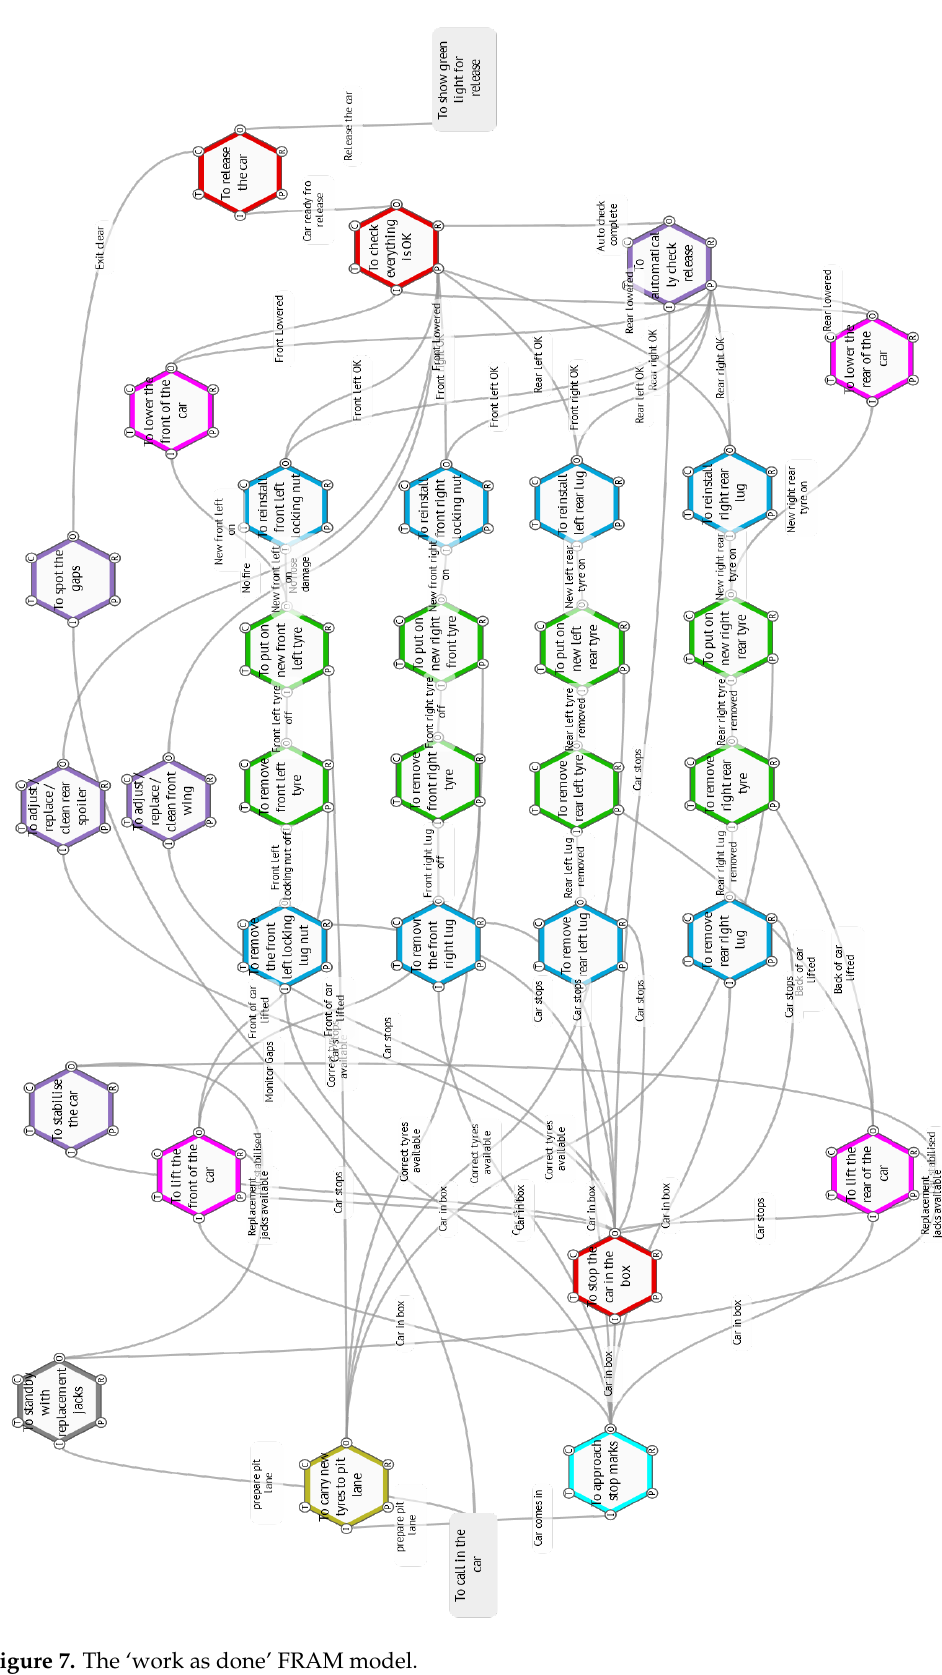
Figure 7. The ‘work as done’ FRAM model.